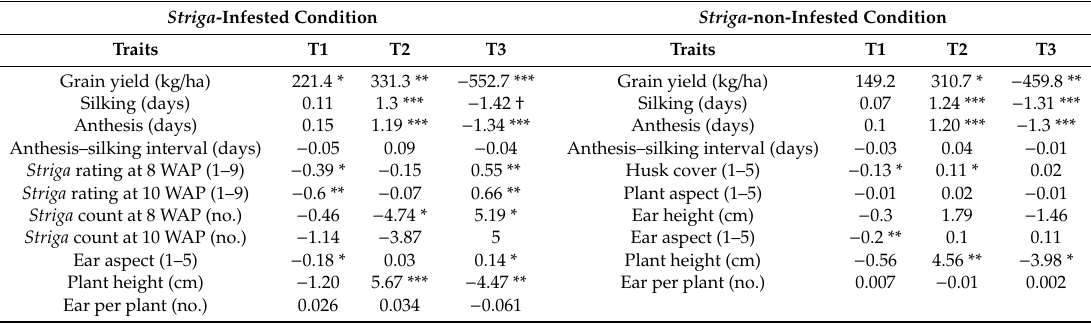
Table 7. Estimates of general combining ability (GCA) e ff ects for three testers under Striga -infested and non-infested